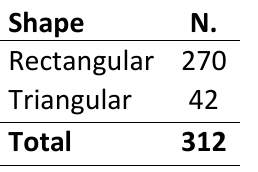
Table 3. Shape of target objects.